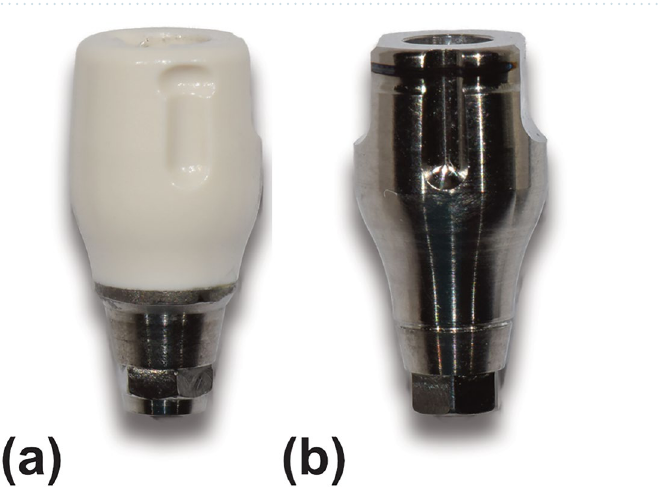
Figure 1. Study groups based on implant angulation and scan body materials. ( a ) Parallel implants with polyetheretherketone (PEEK) scan bodies. ( b ) Vertically placed mesial implant and 15° mesially tilted distal implant with PEEK scan bodies. ( c ) Vertically placed mesial implant and 15° lingually tilted distal implant with PEEK scan bodies. ( d ) Parallel implants with titanium scan bodies. ( e ) Vertically placed mesial implant and 15° mesially tilted distal implant with titanium scan bodies. ( f ) Vertically placed mesial implant and 15° lingually tilted distal implant with titanium scan bodies.